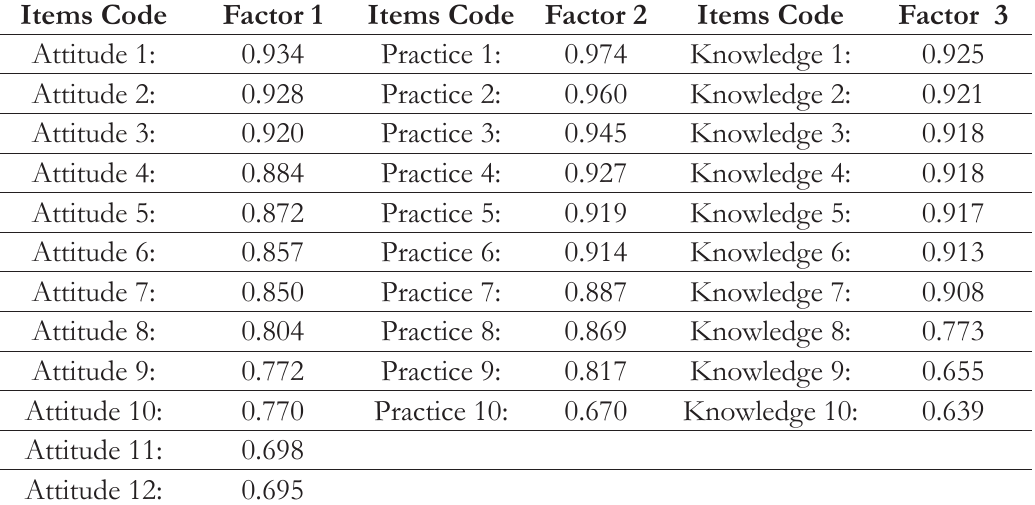
Table 2. Rotated Factors Loading